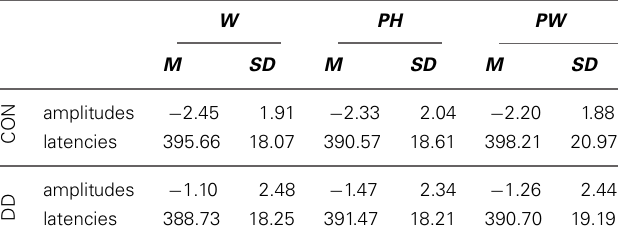
Table 4 | N400 mean peak amplitudes ( μ V) and latencies